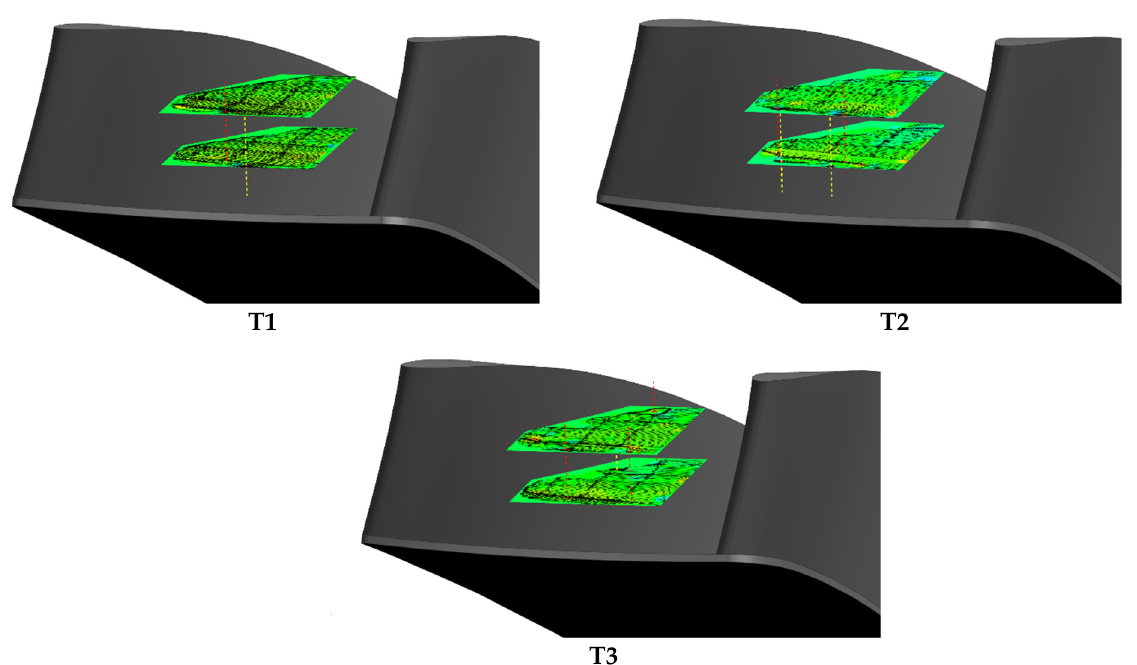
Figure 15. Developed vortex conditions at high unit speeds. T1–T3 is the moment of shooting